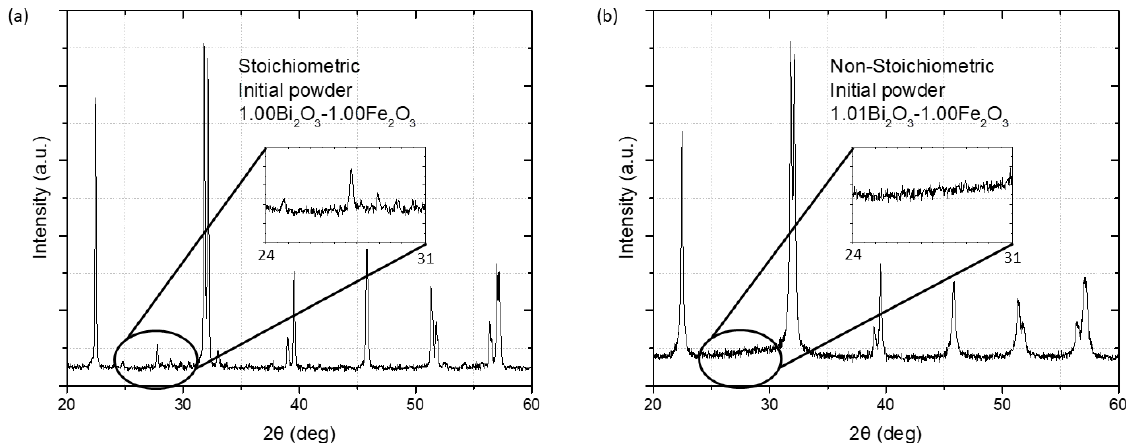
Figure 4. X-ray diffraction analysis of samples prepared with and without the addition of extra bismuth. (( a ) Equal amounts of iron and bismuth in the precursor; ( b ) 1 mol% extra bismuth oxide added to precursor).